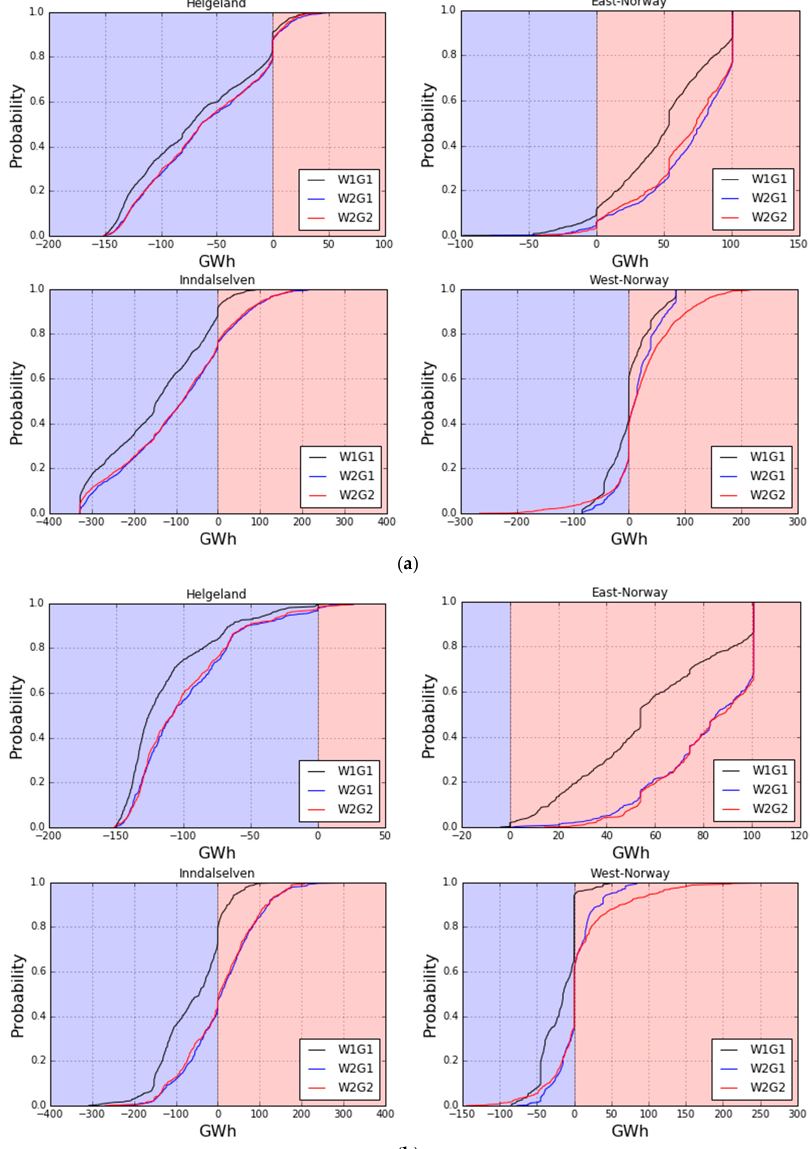
Figure 4. Cumulative distribution functions of weekly energy exchanges between Mid-Norway and the neighbouring regions during: ( a ) the whole year; and ( b ) the winter season only. Negative (blue background) and positive (red background) values, respectively, show importation to and exportation from Mid-Norway. Note than only the line with West-Norway is reinforced in G2 scenario. Note that some distributions clearly show when the full capacity is reached for the whole week (e.g., East-Norway).